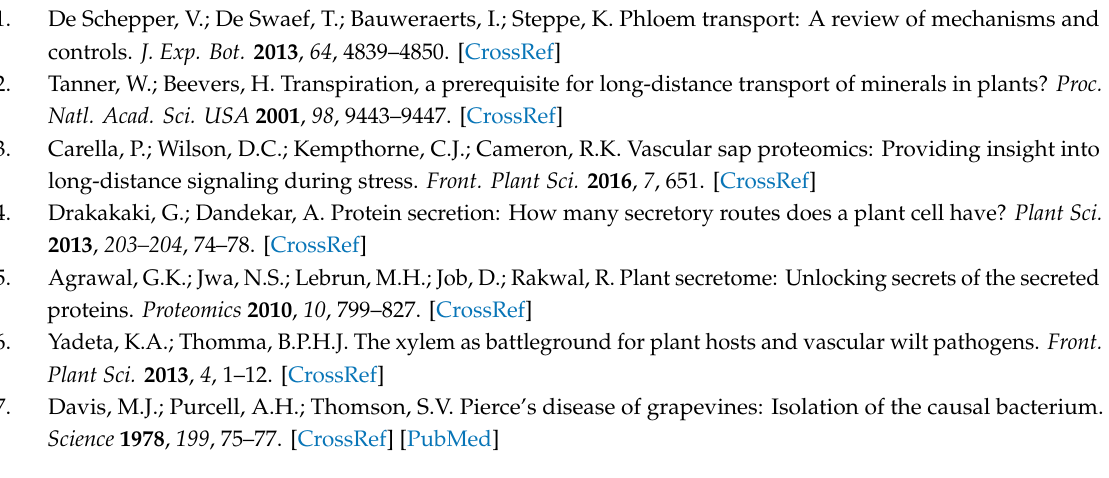
Figure S1: Heatmaps for (a) GPF DIA and (b) DIA + Prosit; Figure S2: PLS-DA analysis of 139 proteins identified in both (a) GPF DIA and (b) DIA + Prosit methods and respective (c,d) cross-validation analysis; Table S1: Quantification of Xf cells by qPCR in leaf sap samples. Standard curve R 2 = 0.985; Table S2: Proteomics data of V. vinifera leaf sap using data-independent acquisition (GPF DIA); Table S3: Proteomics data of Xf in the leaf sap using data-independent acquisition (GPF DIA); Table S4: Proteomics data of V. vinifera leaf sap using data-independent acquisition implemented with Prosit (DIA + Prosit) using edgeR package; Table S5: Proteomics data of Xf in the leaf sap using data-independent acquisition implemented with Prosit (DIA + Prosit); Table S6: Venn Diagram Analysis of V. vinifera proteome; Table S7: Venn Diagram Analysis of Xf proteome; Table S8: Gene ontology analysis of V. vinifera by Panther; Table S9: Summary of enrichment analysis by Metascape for increased proteins ( Arabidopsis ID); Table S10: Summary of enrichment analysis by Metascape for decreased proteins ( Arabidopsis ID), Notebooks (R): Gas-phase fractionation experimental library approach (DIA_Sca ff old_edgeR.html), Prosit theoretical library approach